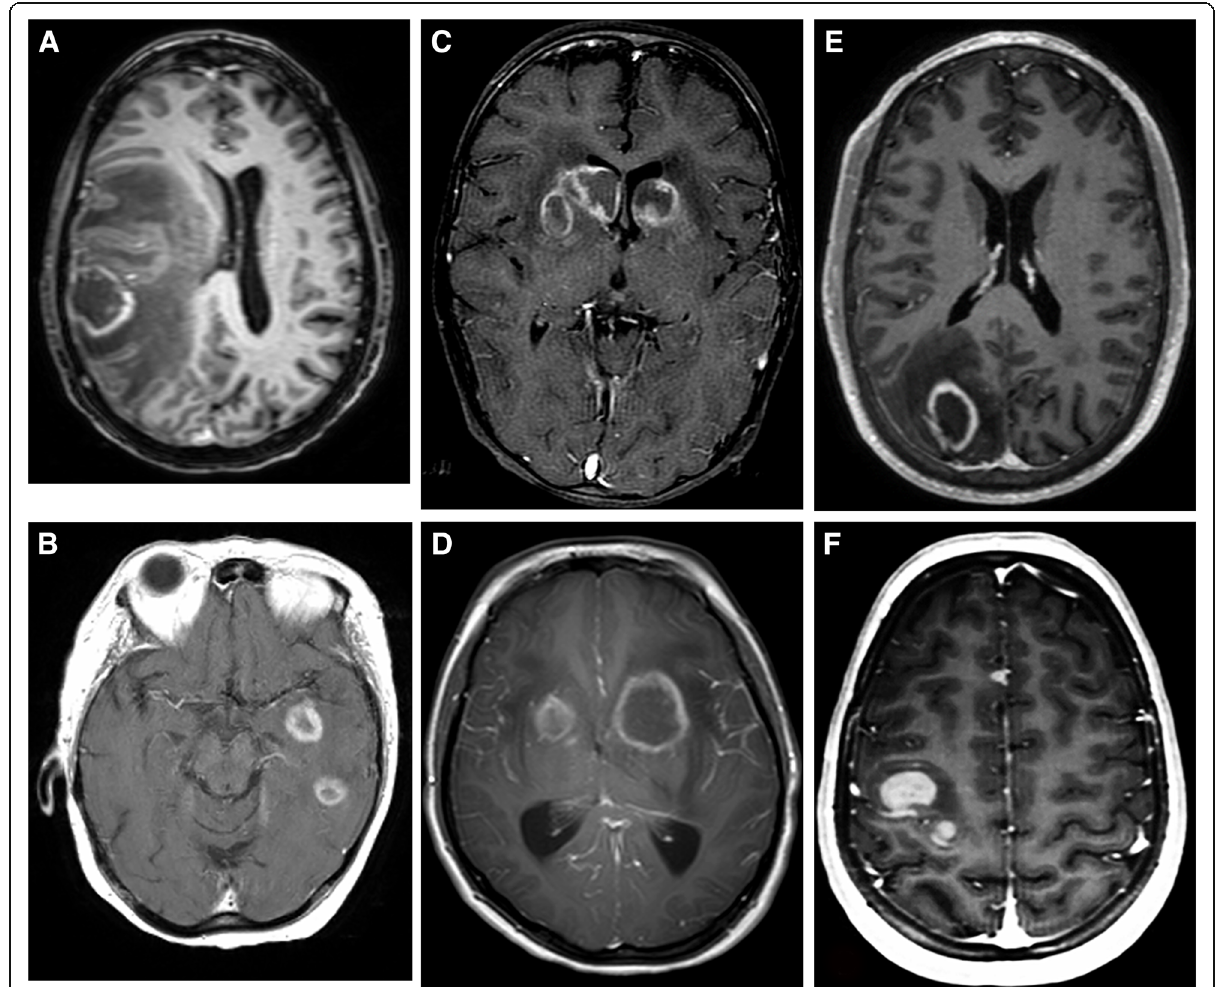
Fig. 2 CNS-PTLD T1-weighted post-gadolinium images in six cases ( a - f ). In these cases, the lesions are predominantly ring enhancing. Although, case f has two solid enhancing lesions. There are no solid enhancing periventricular lesions as typically seen in CNS lymphoma. The location of lesions in the basal ganglia in cases c and d would be unusual for metastatic